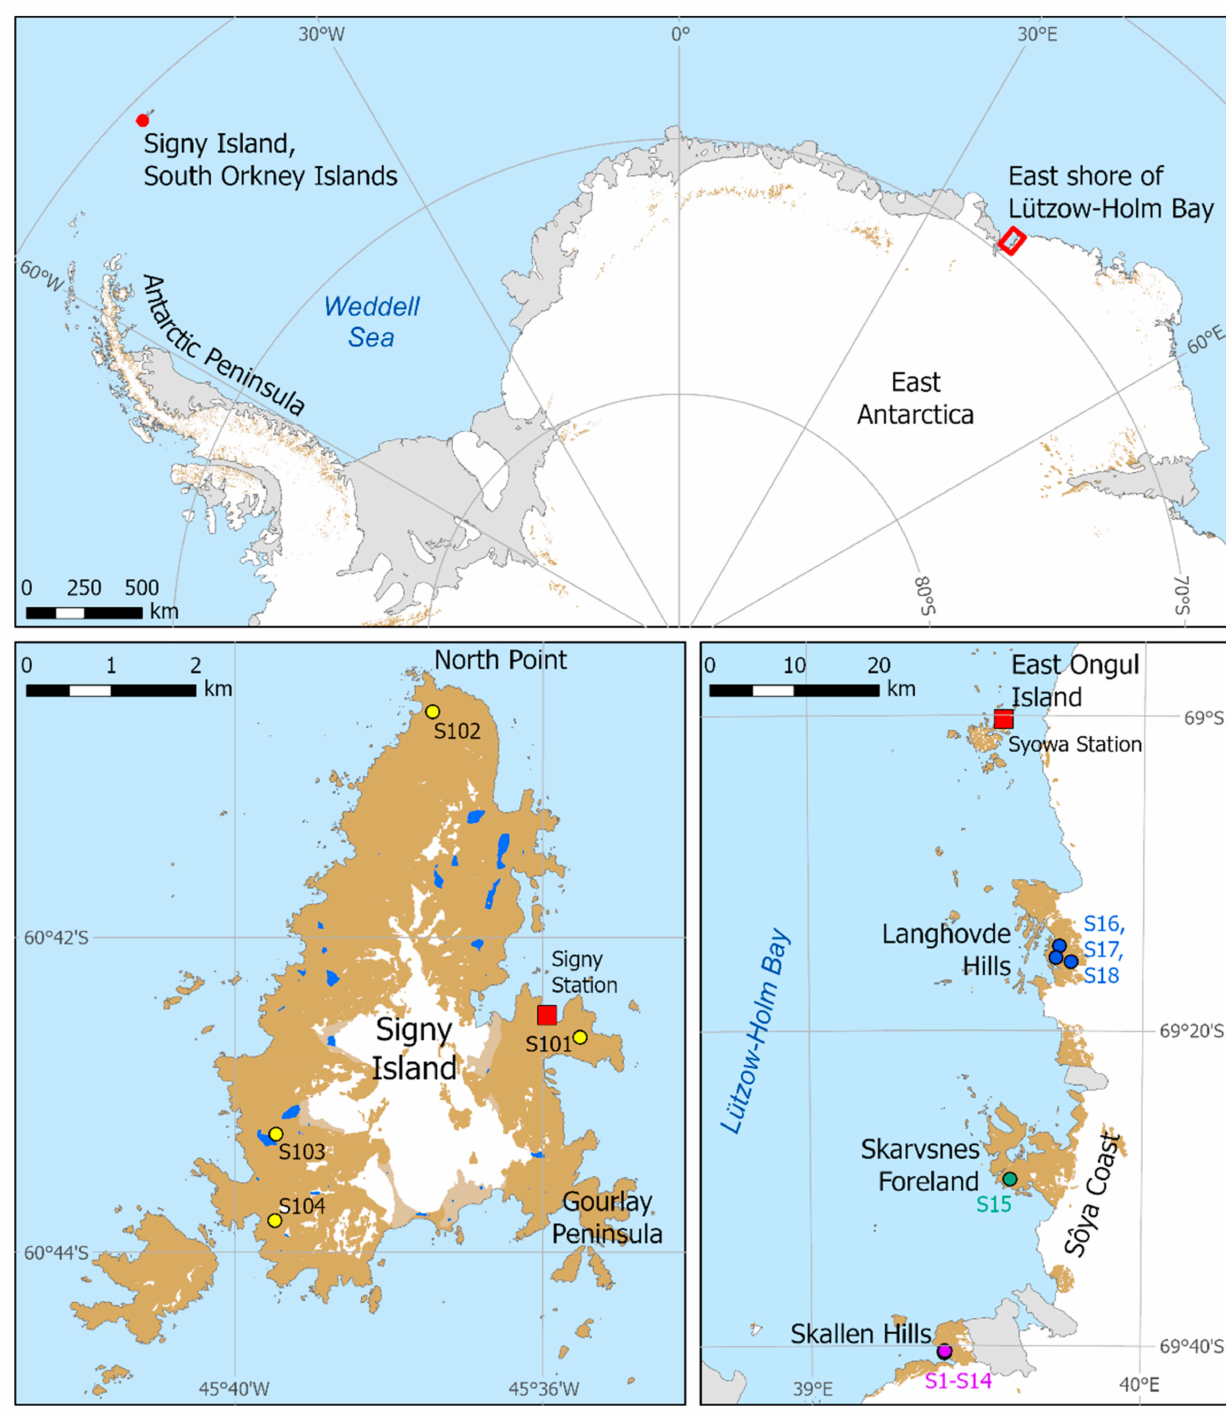
Figure 1. Locations of sampling sites of rock tripe lichen specimens on Signy Island (South Orkney Islands, maritime Antarctic) and the east shore of Lützow-Holm Bay, coastal Queen Maud Land, continental Antarctica. Upper panel, overview of the locations of the two sampling regions. Lower left, detailed map of Signy Island. Lower right, detailed map of the east shore of Lützow-Holm Bay near Syowa Station, showing three areas of sample collection; further details of sampling sites in the Skallen Hills are listed in Table